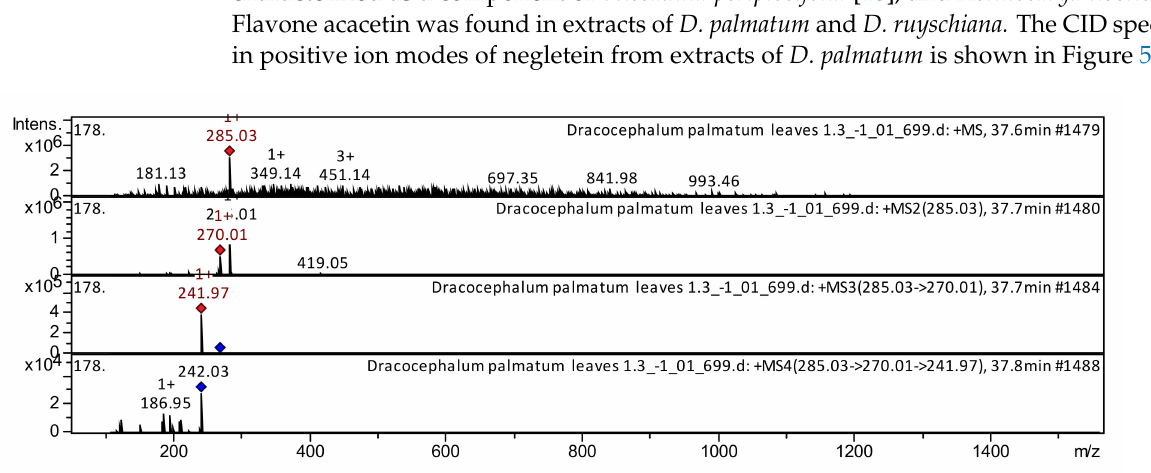
Figure 5. CID spectrum of negletein from extracts of D. palmatum , m / z